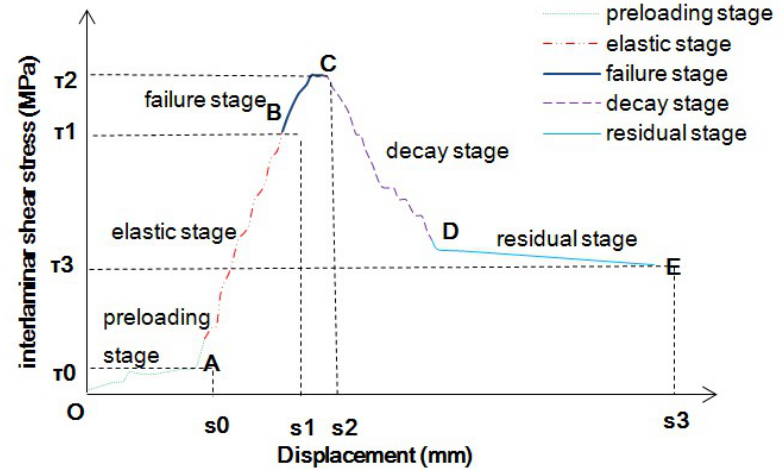
Figure 4. Four interlaminar shear stress and displacement curves.